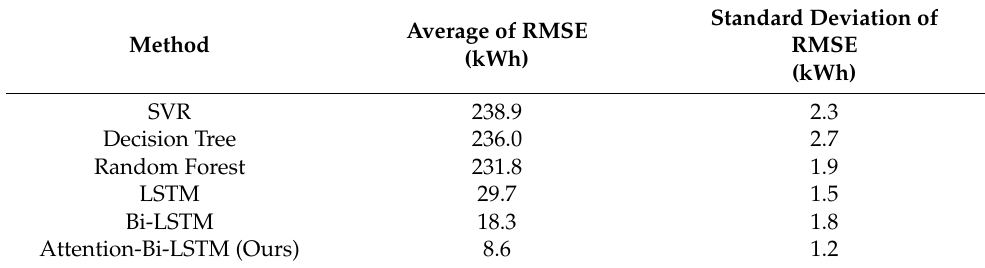
Table 6. Statistical analysis on the studied